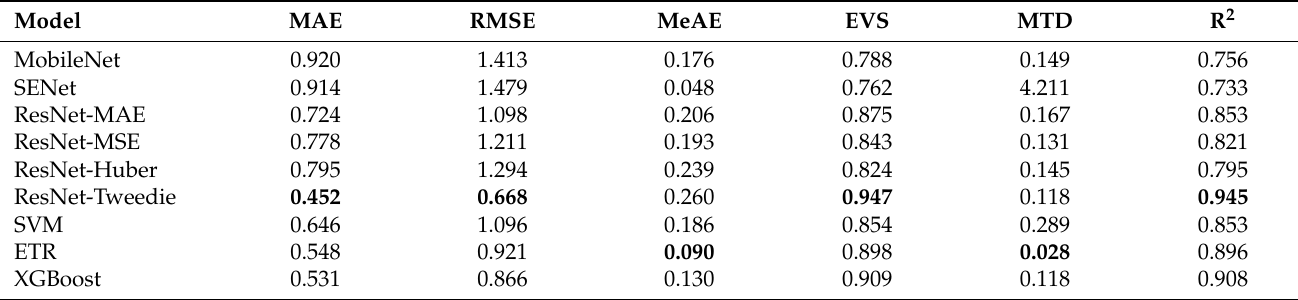
Figure 8. The unbalanced force identification results of each model. ( a ) MobileNet; ( b ) SENet; ( c ) ResNet-MAE; ( d ) ResNet-MSE; ( e ) ResNet-Huber; ( f ) ResNet-Tweedie; ( g ) SVM; ( h ) ETR; ( i ) XGBoost. Table 4. The identification results of each